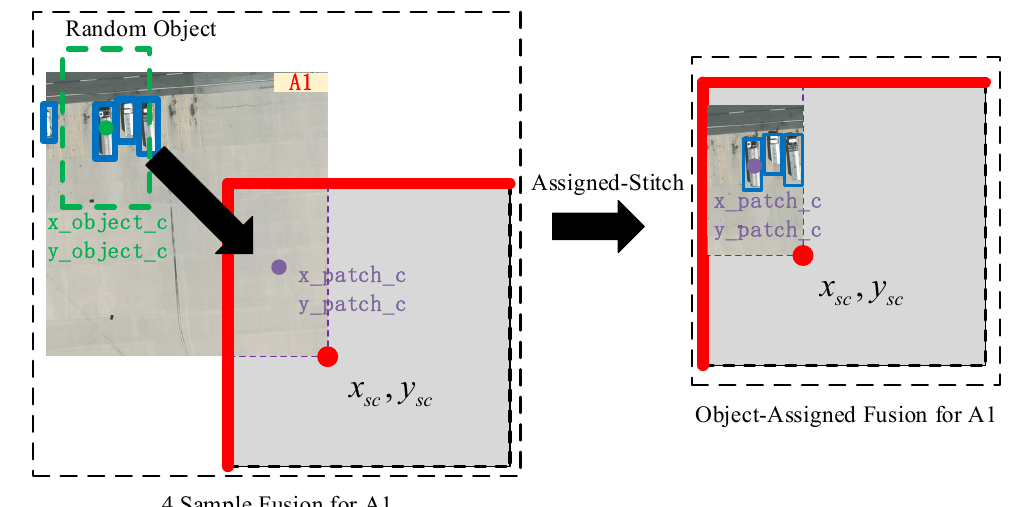
Figure 8. Assigned-Stitch for A1 image. In Figure 8, the purple rectangle denotes the location of the A1 sample, with center ( x_patch_c , y_patch_c ). Following this, an object in A1 is randomly selected (green rectangle) with center ( x_object_c , y_object_c ). Note that the green rectangle has the same area as